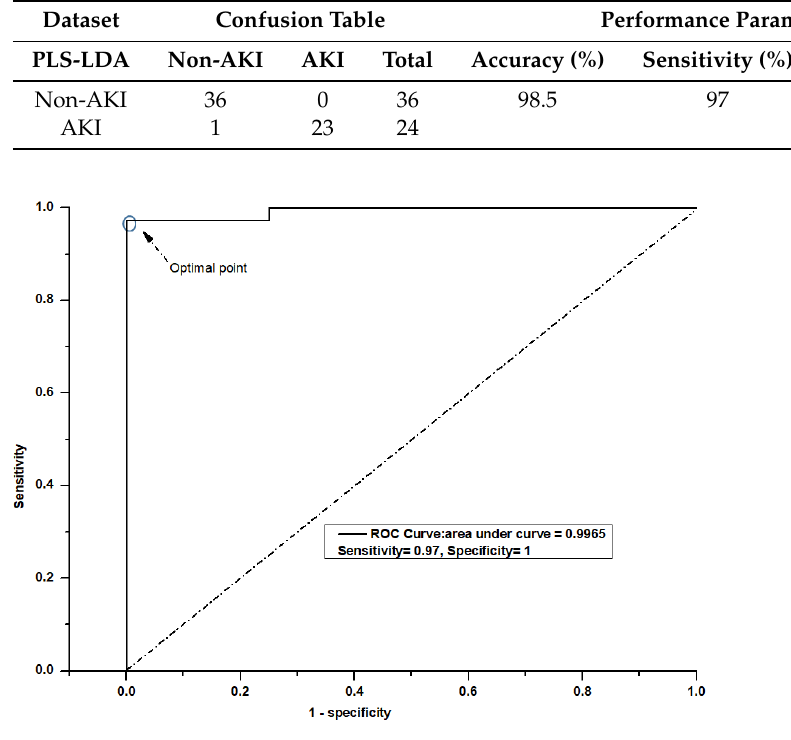
Figure 4. ROC curve of the classification results for the PLS-LDA